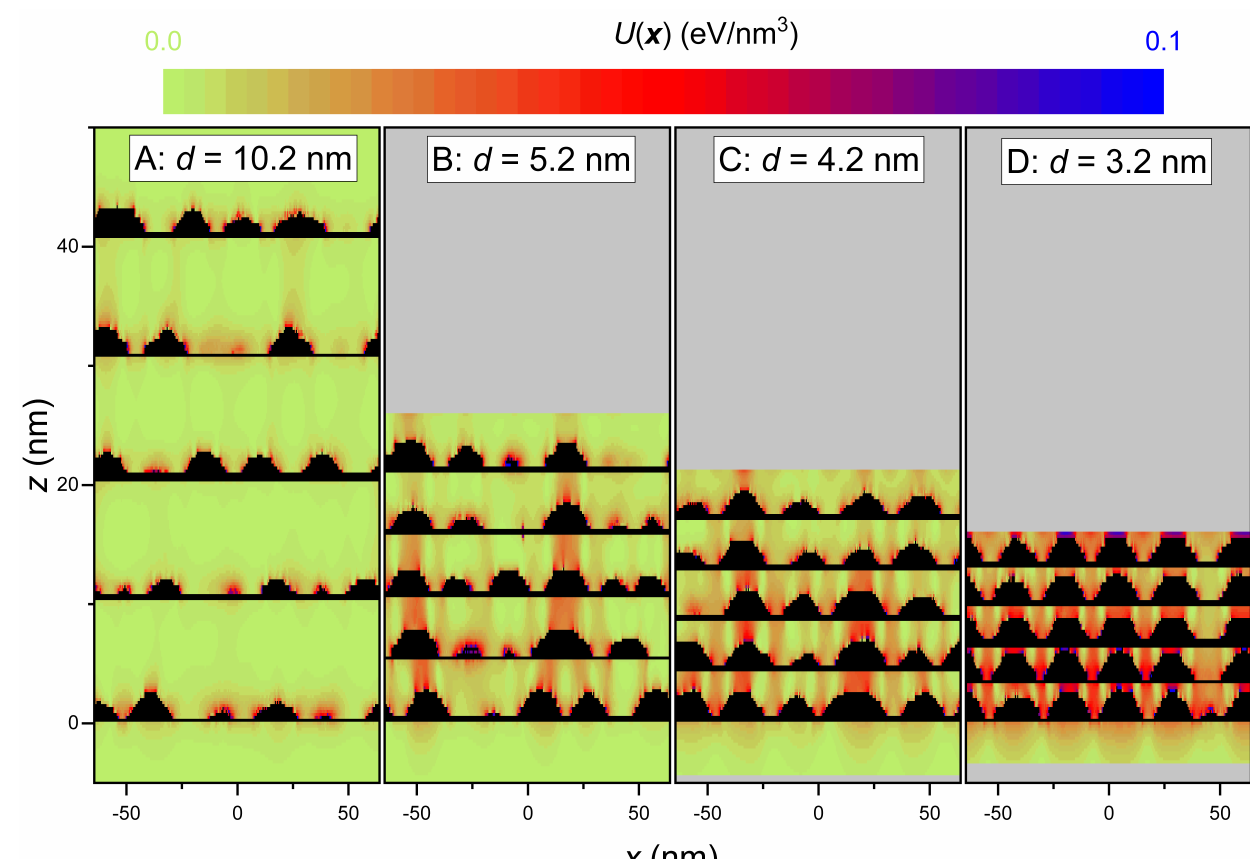
Figure 9. Vertical cross sections through the simulated stacks consisting of five QD layers separated by different spacer thicknesses: d = 10.2 nm (stack A ), d = 5.2 nm ( B ), d = 4.2 nm ( C ), and d = 3.2 nm ( D ). For each stack, the distribution of the elastic energy density U ( x ) is shown by means of a pixelated color map. The color scale has been truncated at 0.1 eV/nm 3 , so that most the GaN volume, which is strained beyond that value, appears as black